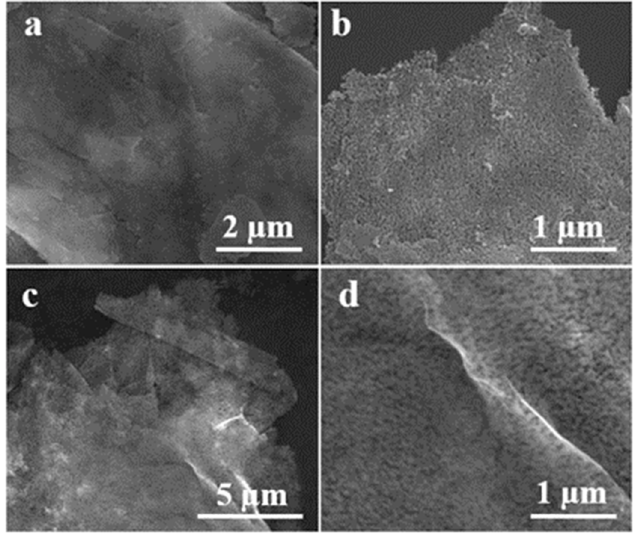
Figure 2. ( a , b ) SEM images of porous ZnO nanosheets, ( c , d ) GO/ZnO nanosheet composites, ( b , d ) are the magnification of ( a , c ),